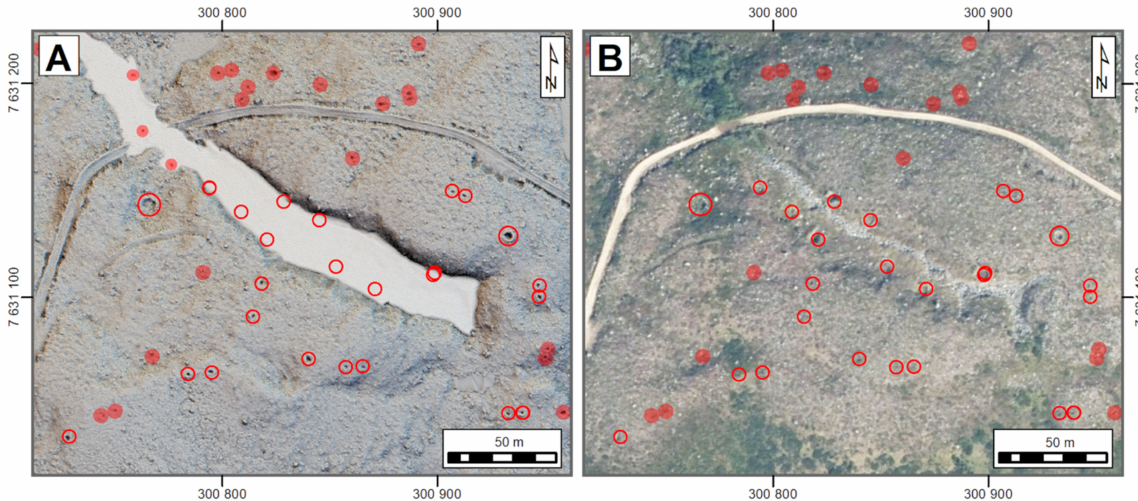
Figure 9. Example of the effects of the snow cover: the archaeological features recorded in the field are shown with open red circles, and the new features detected by the CNN detector D1 are highlighted in red. ( A ) ALS-5p data scanned in late-June 2020, extent of snow cover highlighted with white, note the three false positives detected by D1 within the melting snowfield in the upper left corner, and the features covered by snow (SVF+Multi-HS) [17]. ( B ) Same location in late summer aerial imagery [20], the false positives in snow removed. (EPSG:3879 ETRS89/GK25FIN). (Illustration: Oula